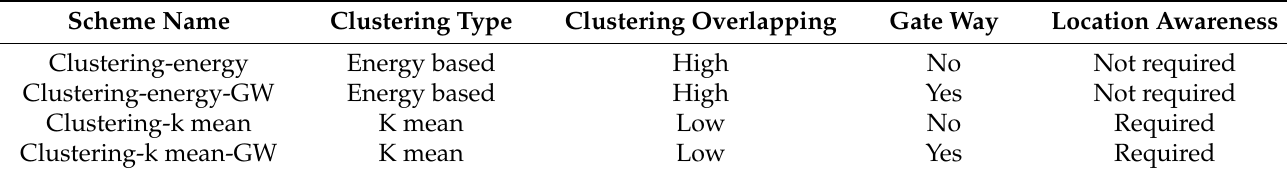
Table 2. Comparison between clustering schemes. GW: